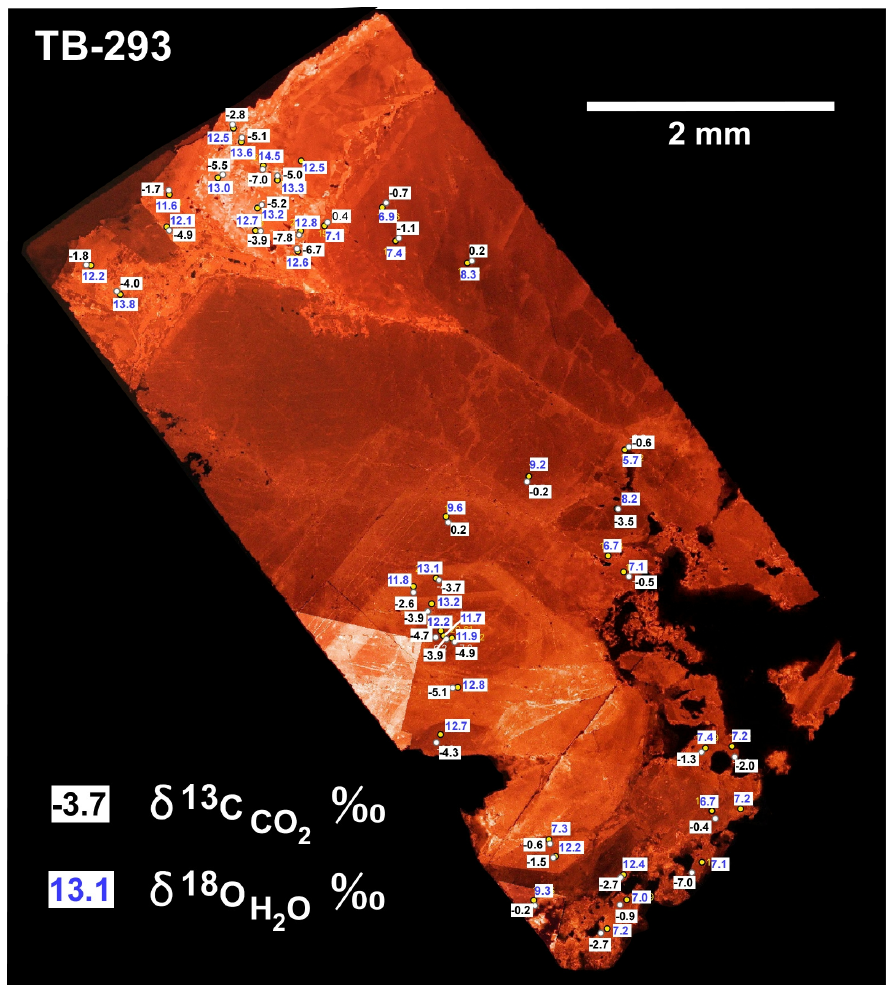
Figure 6. Cathodoluminescence photo of main-stage calcite sample TB-293. TB-293 is a calcite crystal cut perpendicular to the C-axis. Carbon and oxygen isotopic values calculated at constant temperature as δ 18 O H2O and δ 13 C CO2 are shown for the analytical spot locations. Analytical error discussed in text. Data provided in Supplementary Materials.